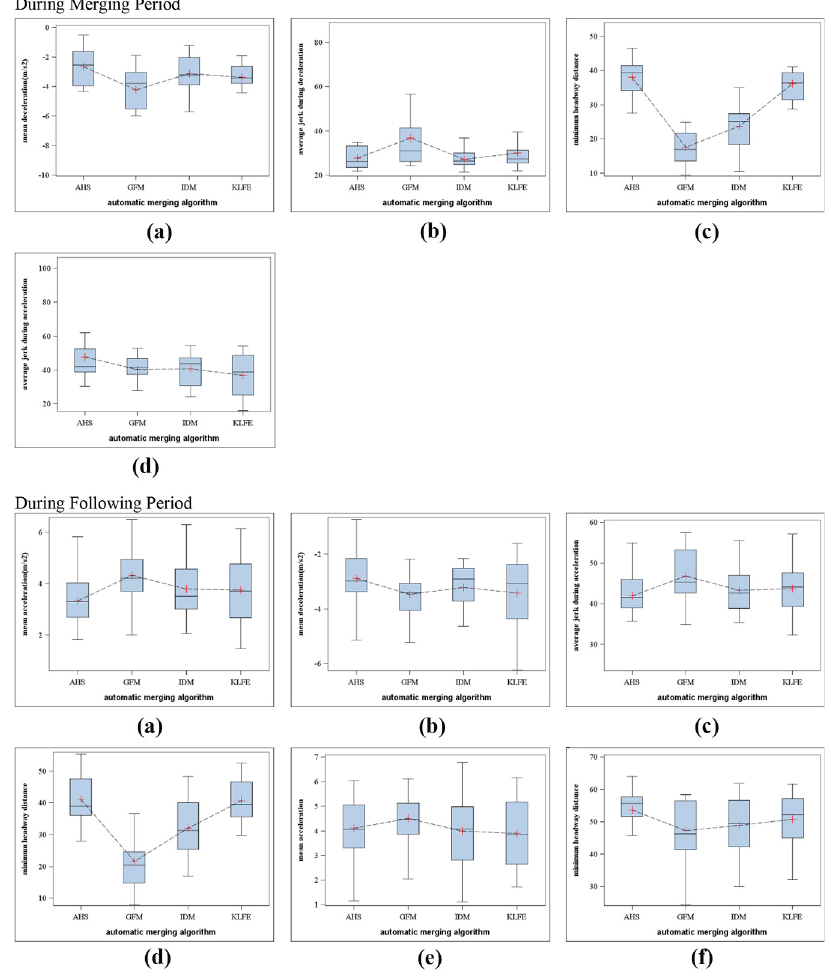
Figure 8 Driving comfort level of automatic merging